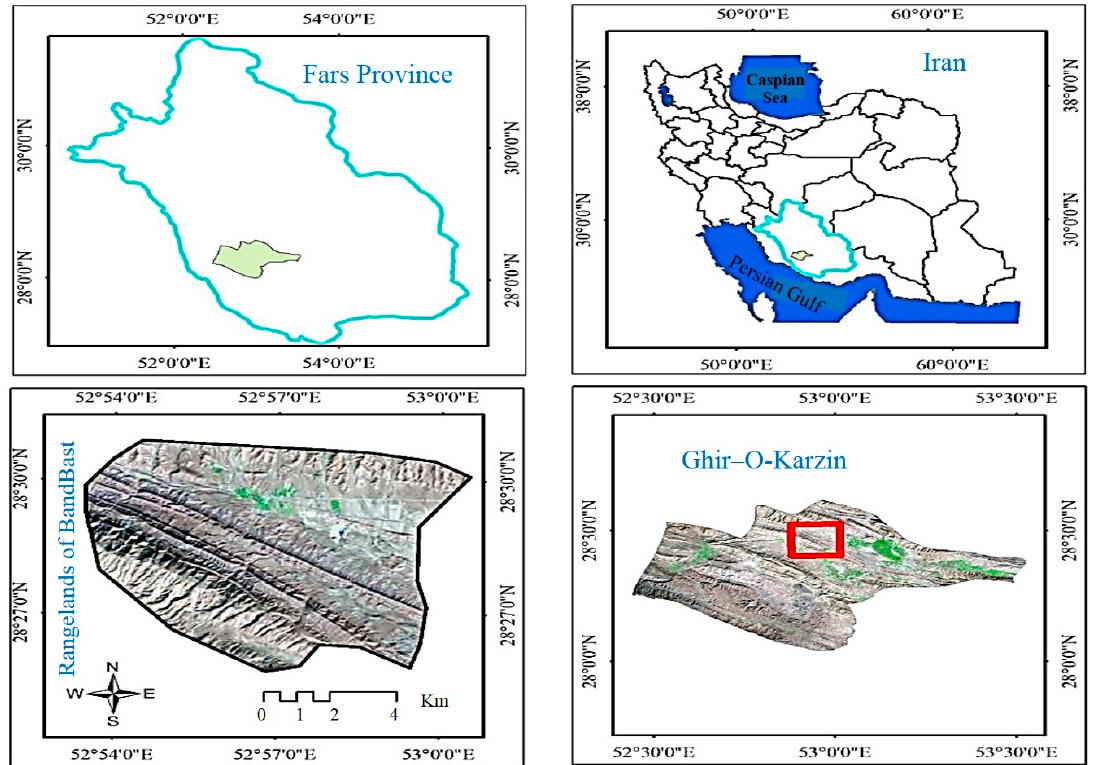
Figure 1. Location map of the BandBast rangelands in the south Iran.